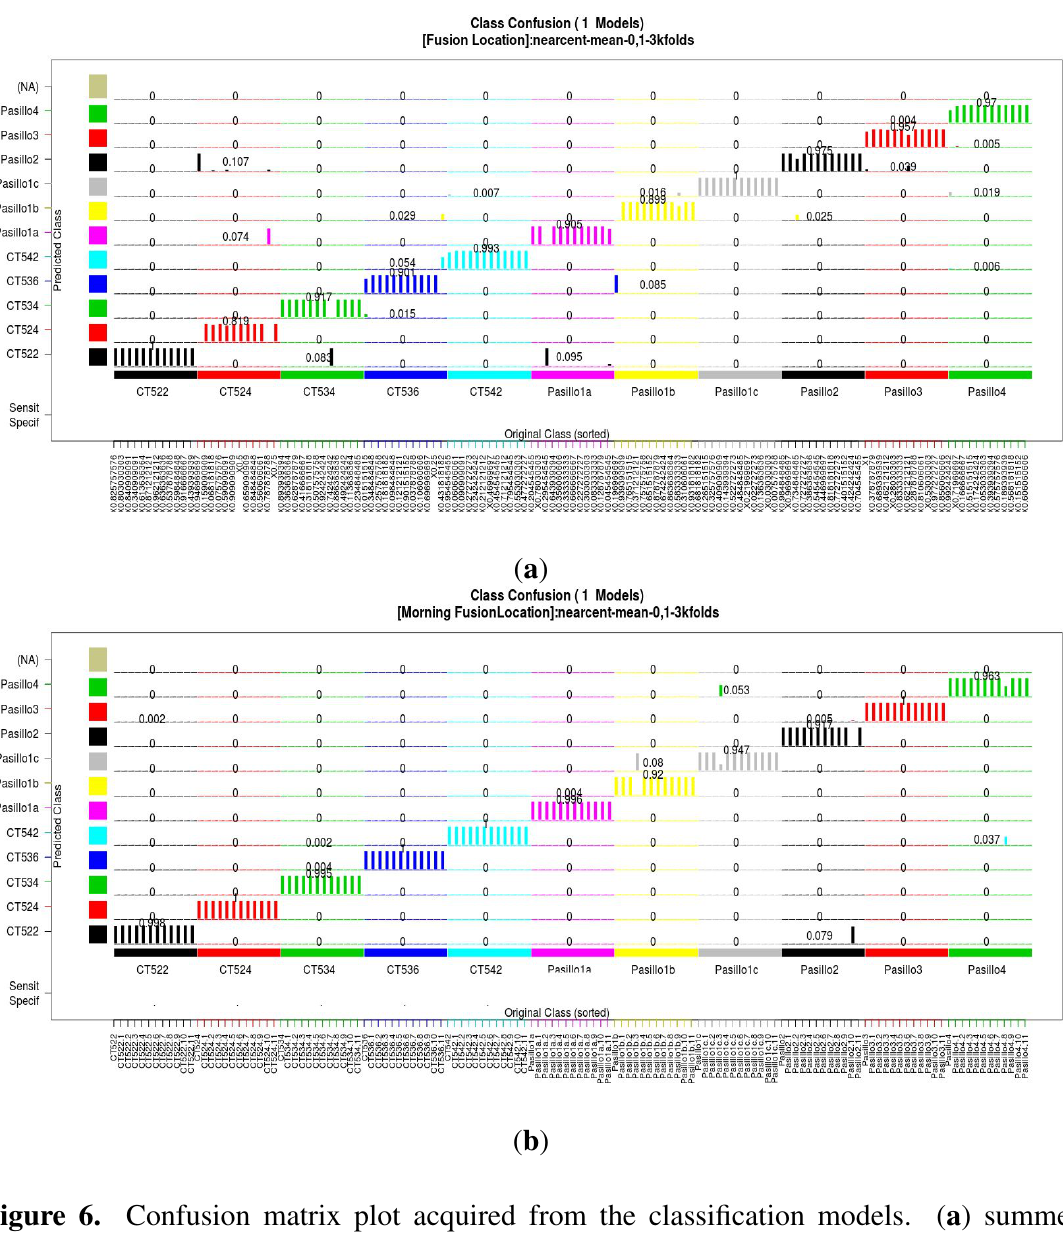
Figure 6. Confusion matrix plot acquired from the classification models. ( a ) summer dataset; ( b ) winter